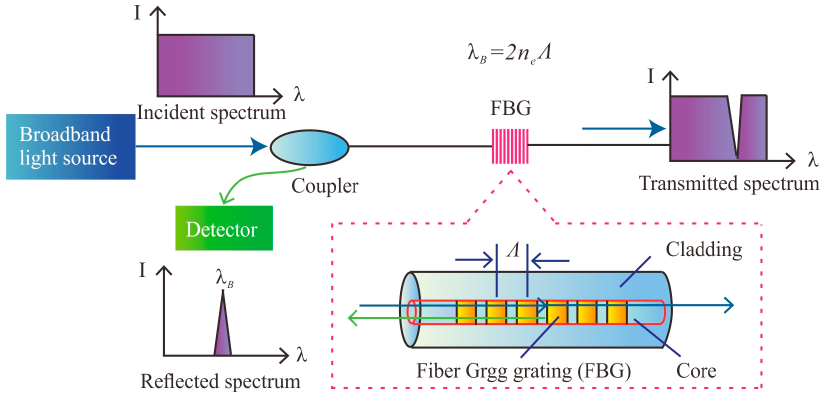
Figure 1. Measuring principles of FBGs.